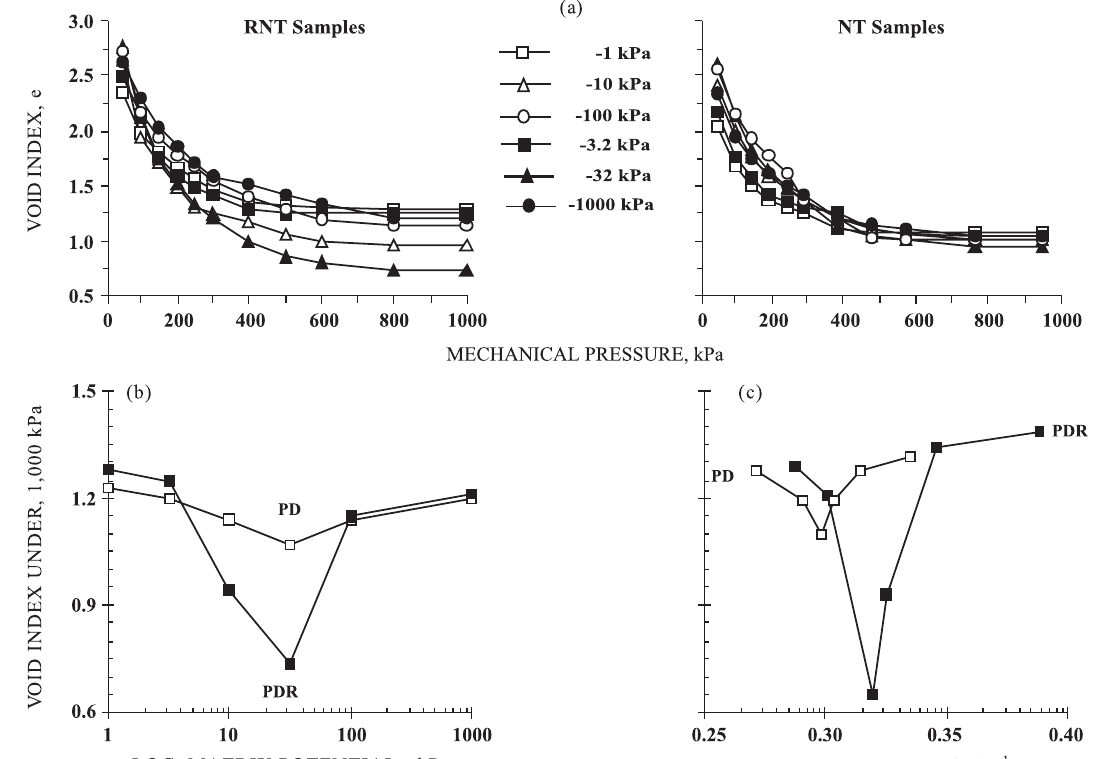
Figure 3. Evolution of void index (e) (average of five repetitions) of aggregates of a Red Oxisol under NT (no- till without crop rotation) and RNT (no-till with rotation), depending on the mechanical pressure involved (kPa) for moisture levels corresponding to matrix potentials of -1, -3.2, -10, -32, -100 and -1,000 kPa (a), and function of matrix potential (b) and final water content